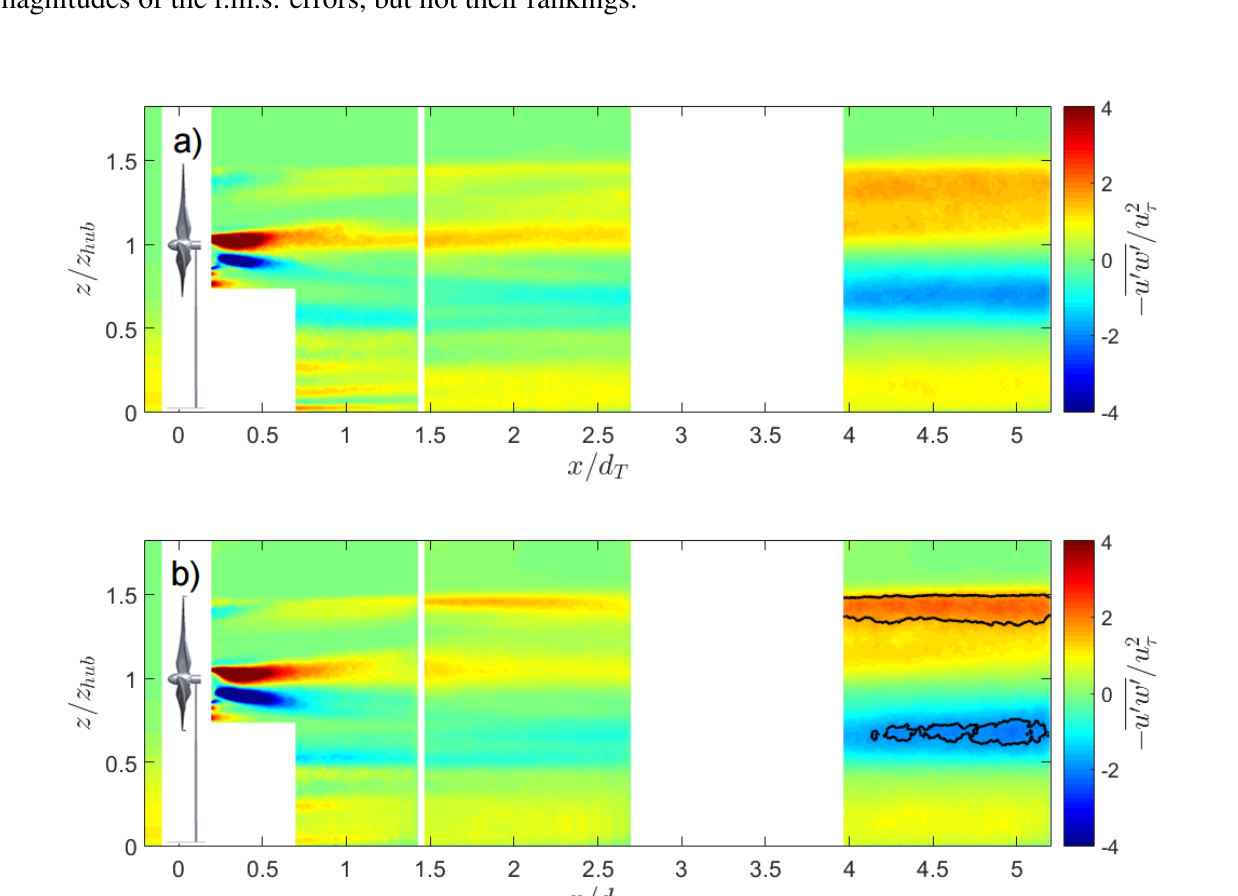
Figure 11. When calculating r.m.s. values for the top or bottom, points reaching from the hub to 1.4R were considered, so as to account for wake expansion (results from the first FOV are excluded due to the strong effect of the generator’s wake). Results indicate that the base turbine is closer to equilibrium than the wingletted one at all downstream locations, and that the lower, more turbulent portion of the wake is also closer to equilibrium. This is likely a result of the higher levels of shear in the wingletted wake that need to be diffused by the turbulence. It should be noted that the analysis above is rather simplified—the model of the Reynolds stress should be, in general, a function of the initial disturbance and radial position (see Johansson et al. [25] for an in-depth discussion of axisymmetric turbulent wakes). The results are not particularly sensitive to the value of b ; changing the value by 50 % in either direction changes the magnitudes of the r.m.s. errors, but not their rankings.